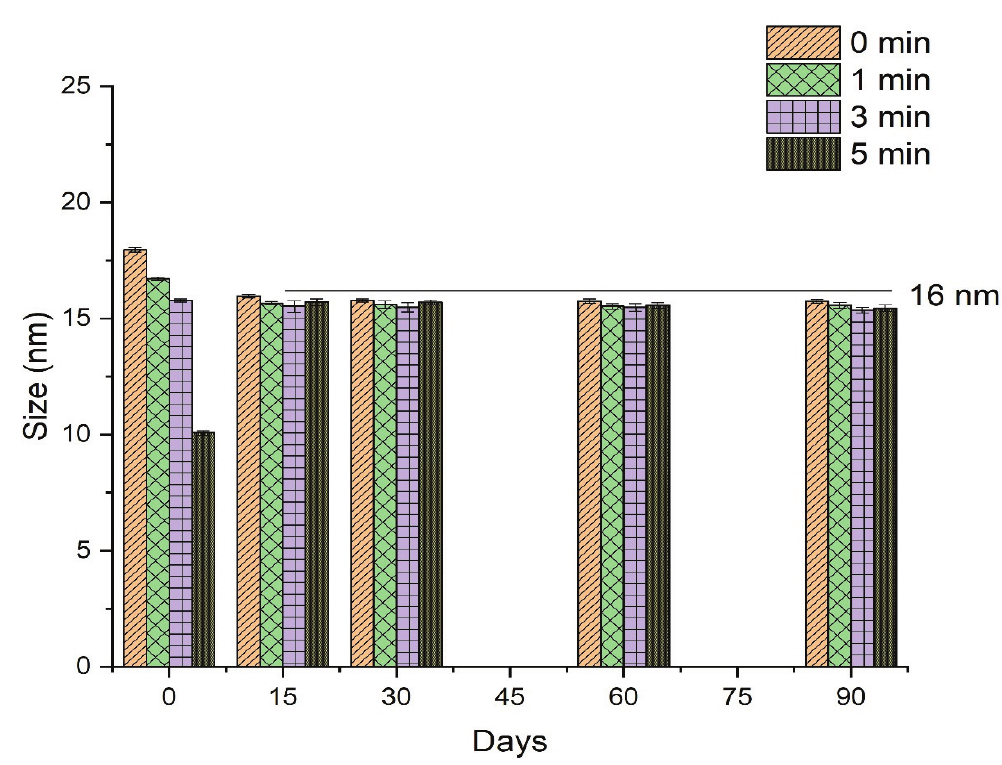
Figure 6. Effect of storage time on mean droplet size of retinyl palmitate-loaded nanoemulsions prepared under different vortexing conditions.